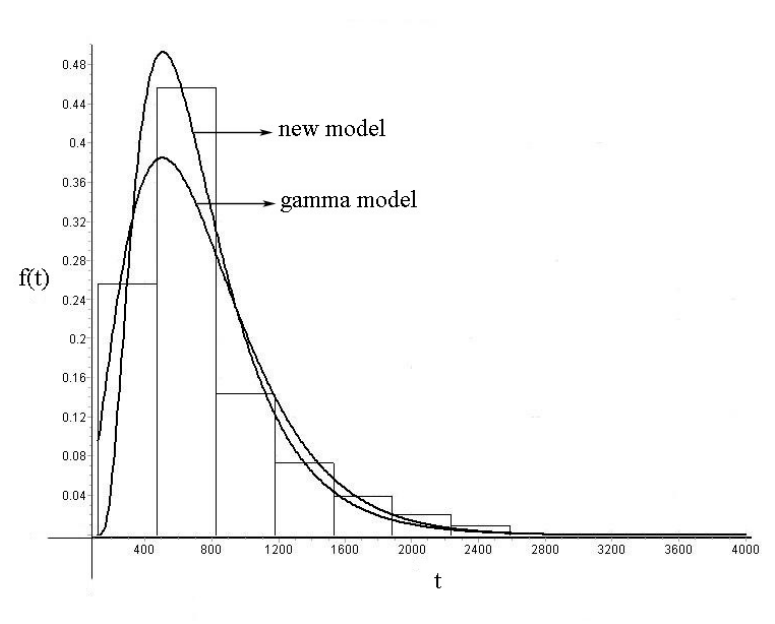
Figure 6. The graph of the histogram embedded with the probability